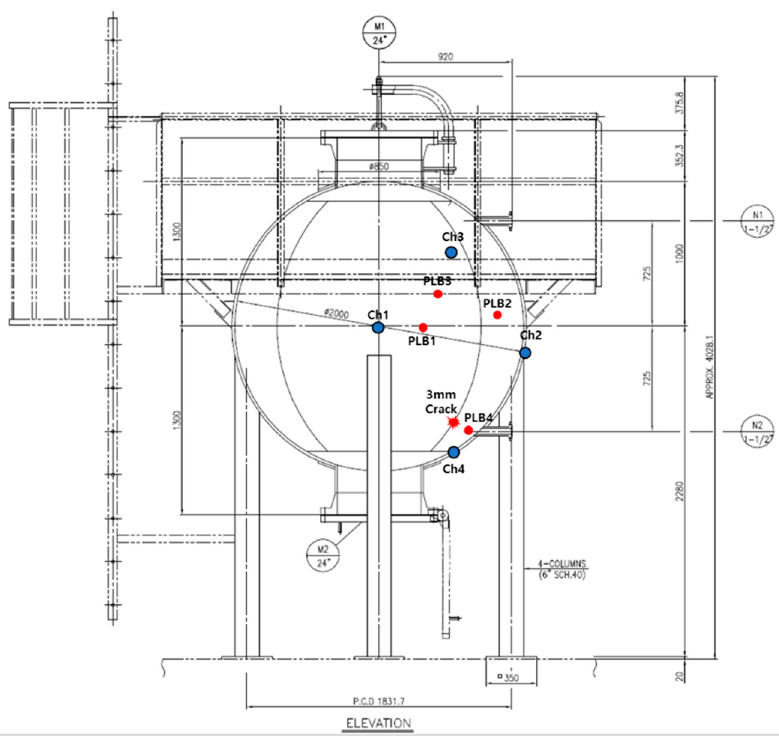
Figure 3. Schematic diagram for a spherical tank testbed.